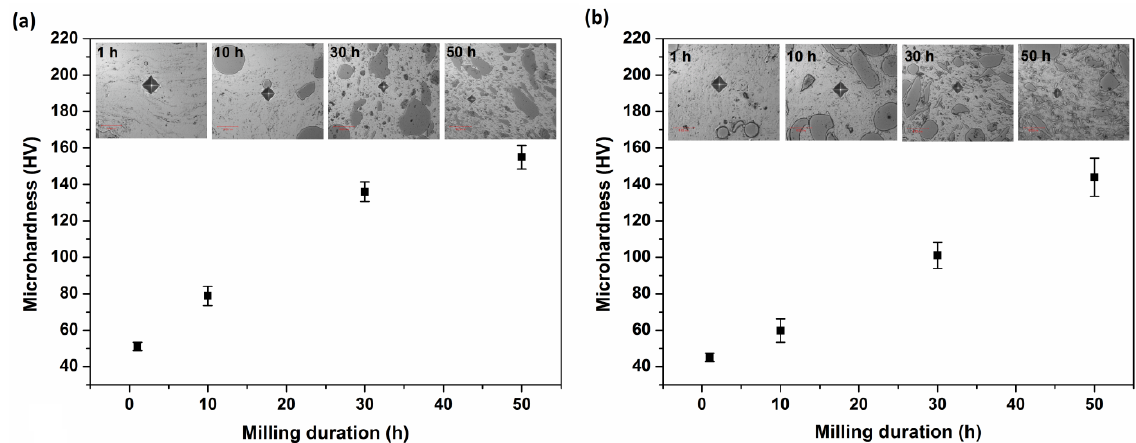
Figure 6. Microhardness values as a function of milling time and optical micrographs of the indentation marks obtained from: ( a ) hot pressed and ( b ) hot pressed and hot extruded composites.